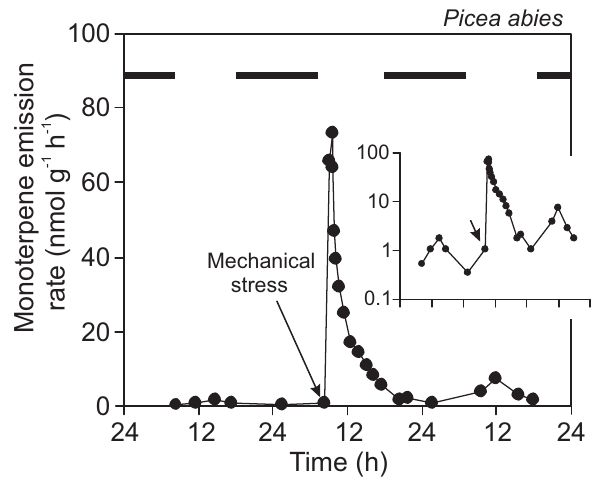
Fig. 6. Effect of mechanical disturbance on monoterpene emis- sions from a 7yr old temperate conifer Picea abies tree. The whole tree crown was enclosed in the chamber (Fig. 2a for the system overview), and the emissions were monitored over three days. In the morning of day 2 the tree was shaken for 3min (denoted by an arrow), causing a sudden increase in the emission rates by almost two orders of magnitude. The inset shows the emissions on a log- arithmic scale, emphasizing that the emissions were still elevated two days after the mechanical stress. Dark periods are denoted by horizontal bars (modified from Staudt,